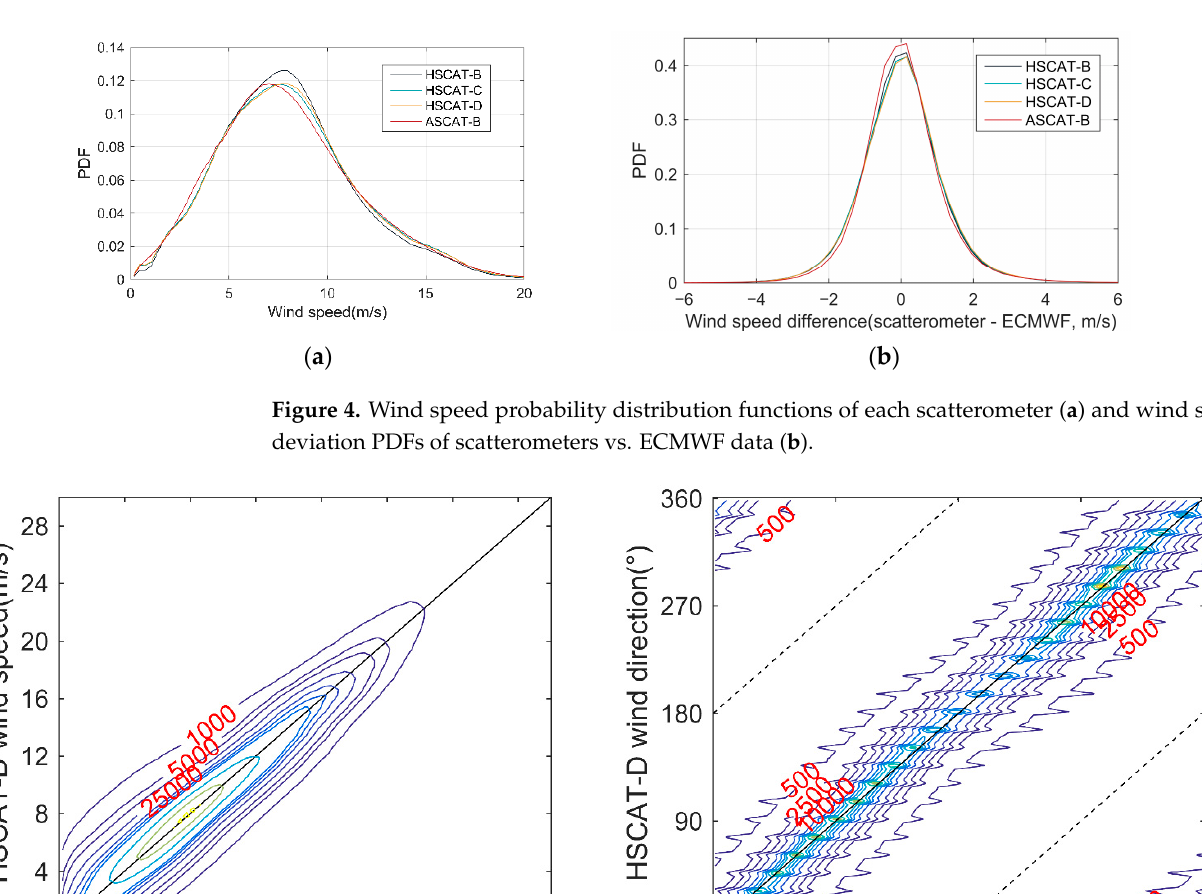
Figure 4. Wind speed probability distribution functions of each scatterometer ( a ) and wind speed deviation PDFs of scatterometers vs. ECMWF data ( b ).